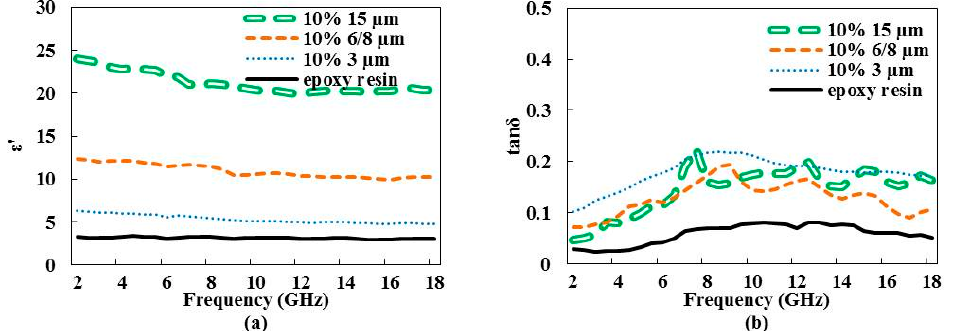
Figure 2. Variation of dielectric constant ε ’ ( a ) and loss tangent tan δ ( b ) vs. frequency of epoxy resin loaded with different graphene particle sizes at a constant weight ratio (10%). Pristine epoxy resin values are given for reference.